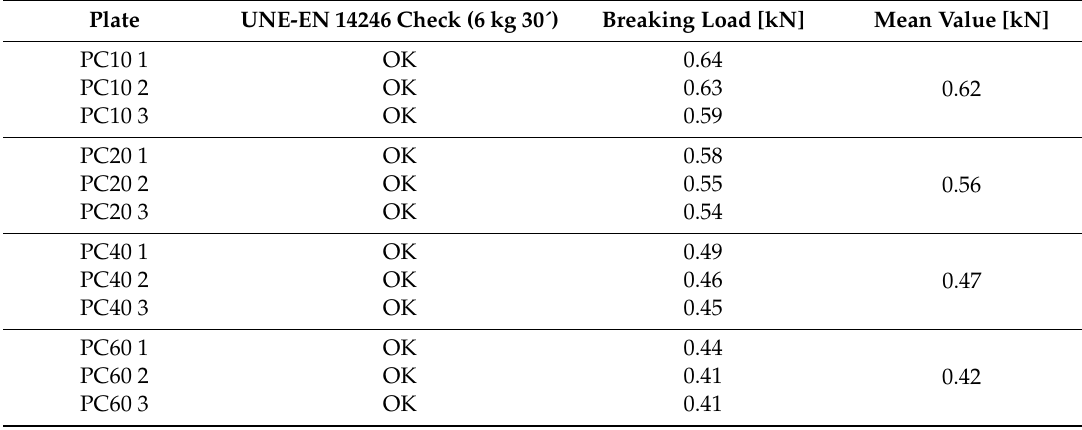
Table 7. Flexural strength test results for the Scenario 1